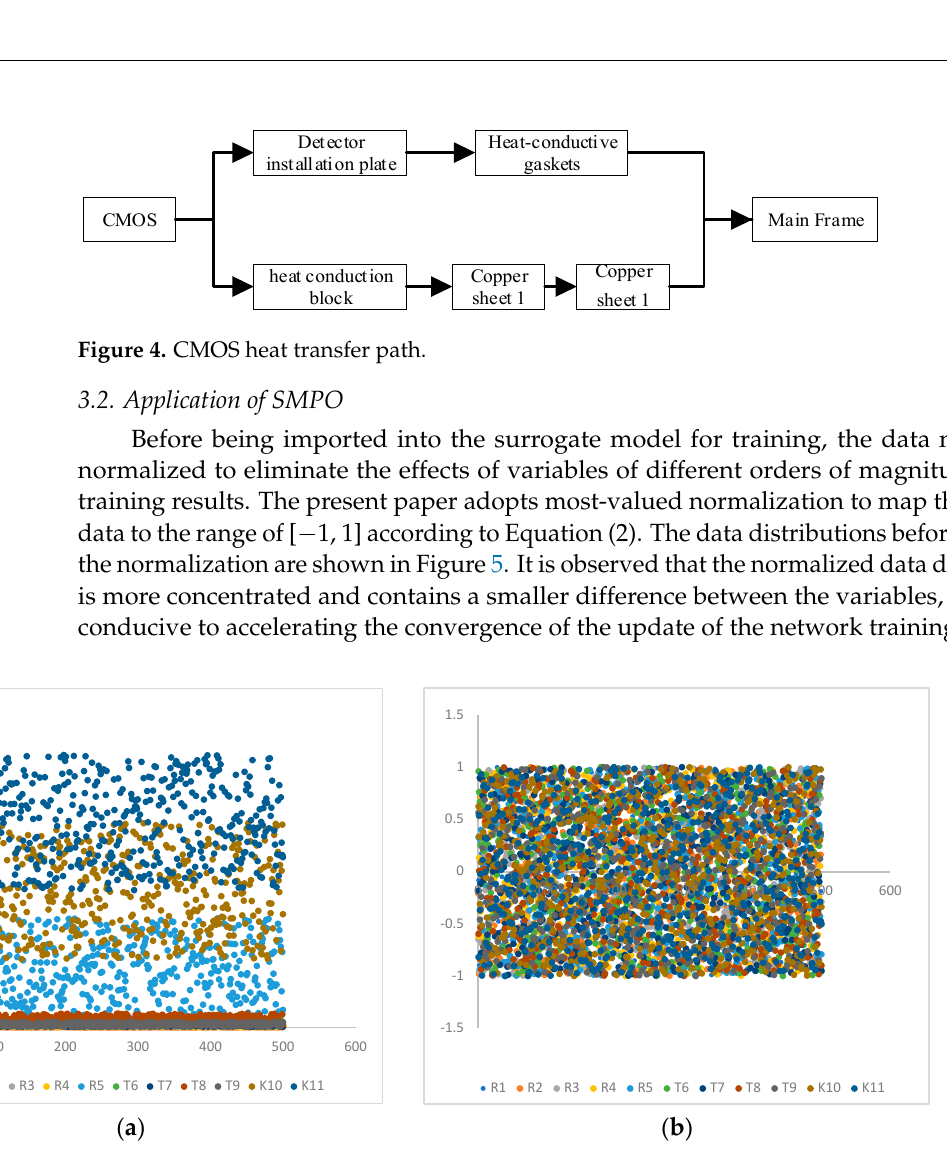
6 of 15 Figure 3. Finite element model of the ADST. Table 1. Definitions of high- and low-temperature cases for the ADST. Cases Definition of Cases High Case